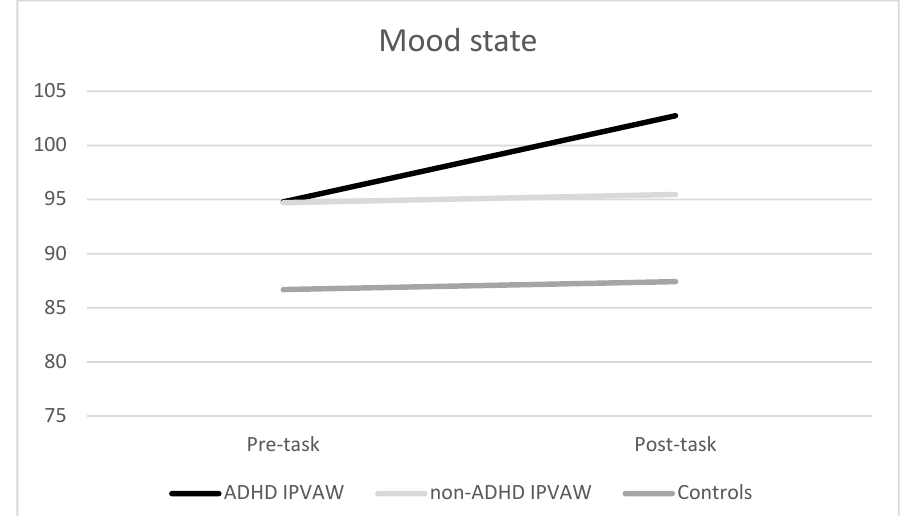
Figure 3. Mood state (Profile of Mood States (POMS)) changes before and after exposure to acute laboratory stressor for all groups. ADHD: Attention Deficit Hyperactivity Disorder; IPVAW: Intimate Partner Violence Against Women.